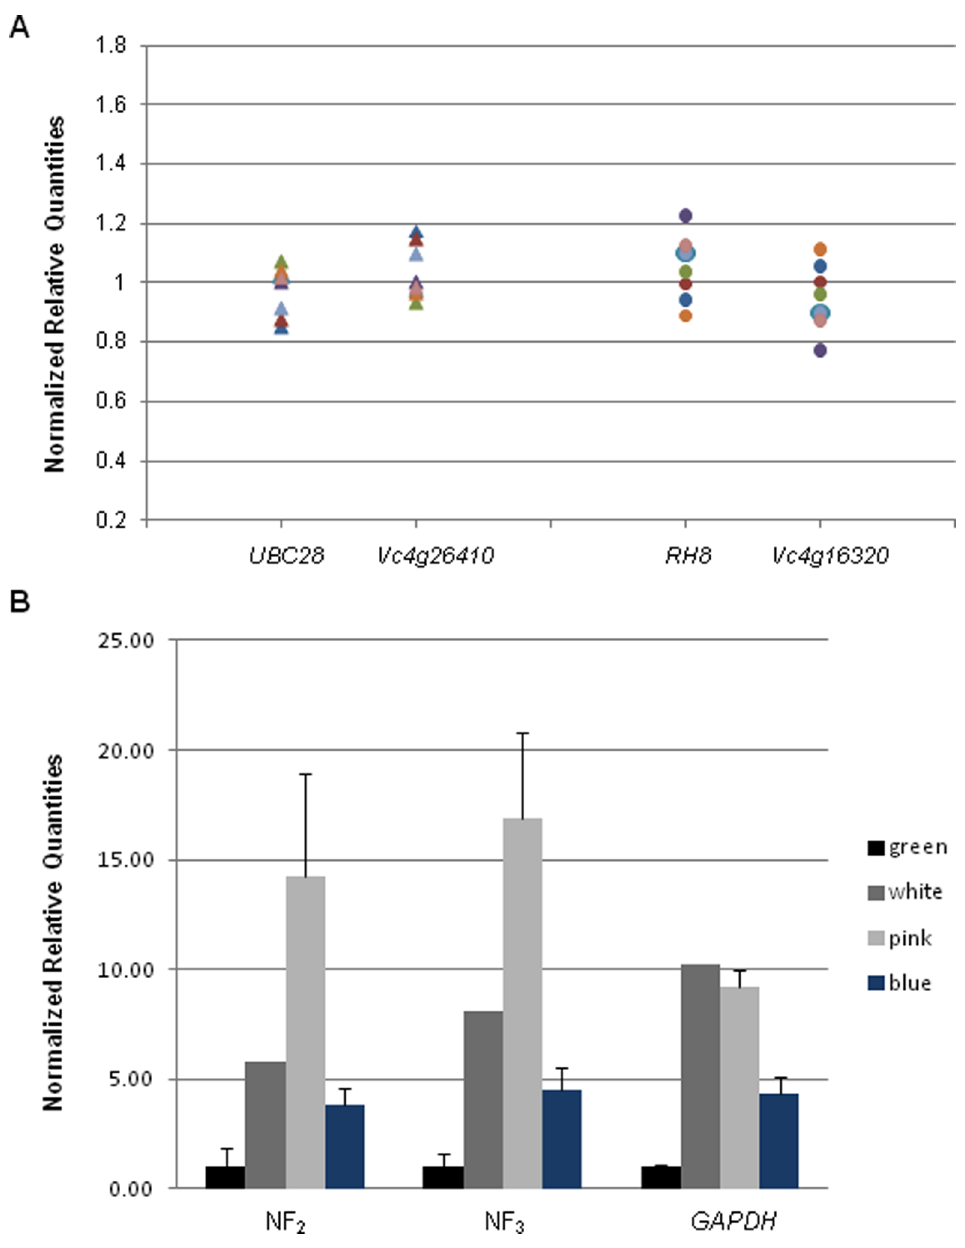
Figure 5. Evaluation of reference genes for blueberry. A. To show the stability of the reference genes, the normalized relative quantities for the best references were calculated in each sample. Fruit samples are represented by triangles and floral buds by circles. B. Normalized relative quantities of PL gene in fruits over four development stages. Three normalization approaches were used: the use of the two or three best-scored genes (NF) and use of a single gene ( GAPDH ) as normalizer. NRQ were rescaled to green that was arbitrarily set as 1.